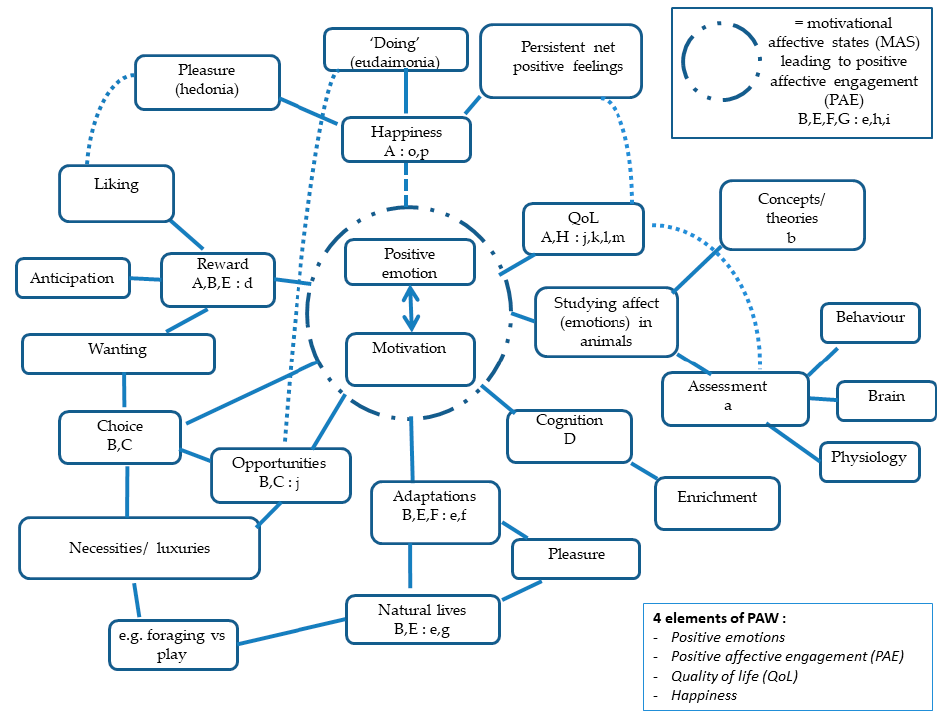
Figure 1. An interpretation of the inter-relationships between the defining elements of PAW and the wider literature. Reference lettering is taken from Table 1 and distinguishes between the core PAW and wider literature. Top right box: provides references to the motivation–emotion nexus; Bottom right box: lists the 4 defining elements. Solid lines between terms indicates a definable link has been made in the literature; dotted lines propose potential links/overlaps. We have not included the dotted line linking the pleasure from performing natural behavior to liking and happiness pleasure as this interferes with the readability of the